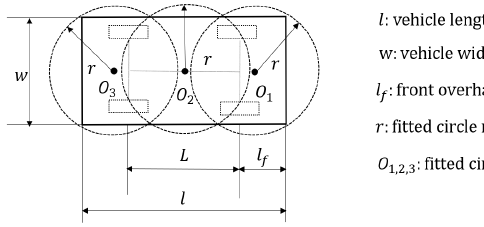
Figure 5. Diagram of the circle fitting strategy.